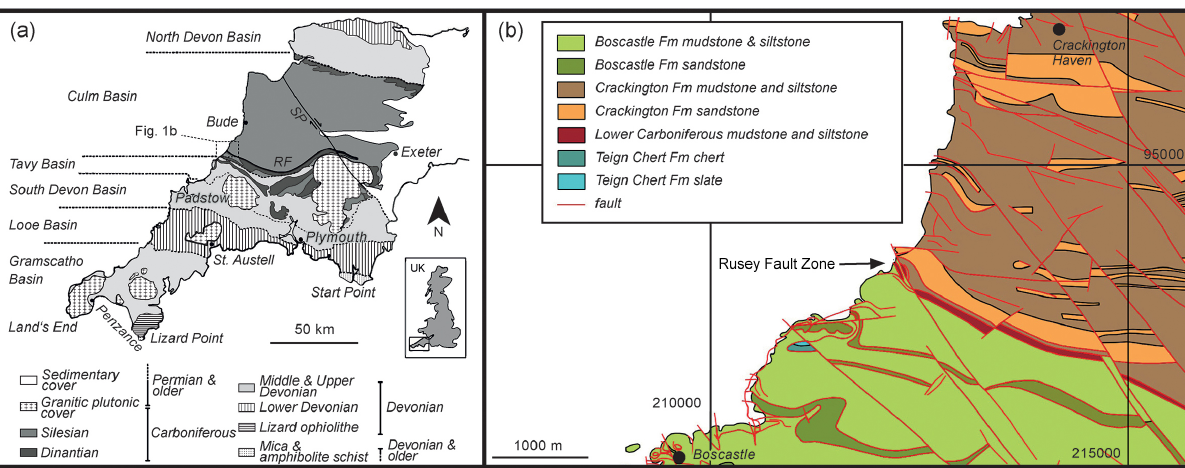
Figure 1. (a) Geological sketch map of Cornwall showing Devonian to pre-Devonian mica and amphibolite schists, Devonian to Carbonifer- ous basins (indicated by short dashed lines), and Upper Carboniferous to Lower Permian granitic intrusions. Furthermore two structures, the Rusey Fault (RF) and the Sticklepath-Lustleigh Fault (SP), are indicated. The dashed rectangle indicates the position of Fig. 1b. Modified after Leveridge and Hartley (2006). (b) Geological and structural map of the Rusey Fault Zone area showing the Boscastle Formation to the south and Crackington Formation to the north of the Rusey Fault Zone. Most faults have an NW–SE to WNW–ESE trend; only a few faults have a NE–SW to ENE–WSW orientation. The position of the Rusey Fault Zone outcrop is indicated by the black arrow. Modified after British Geological Survey 1 : 50000 geological map (British Geological Survey,